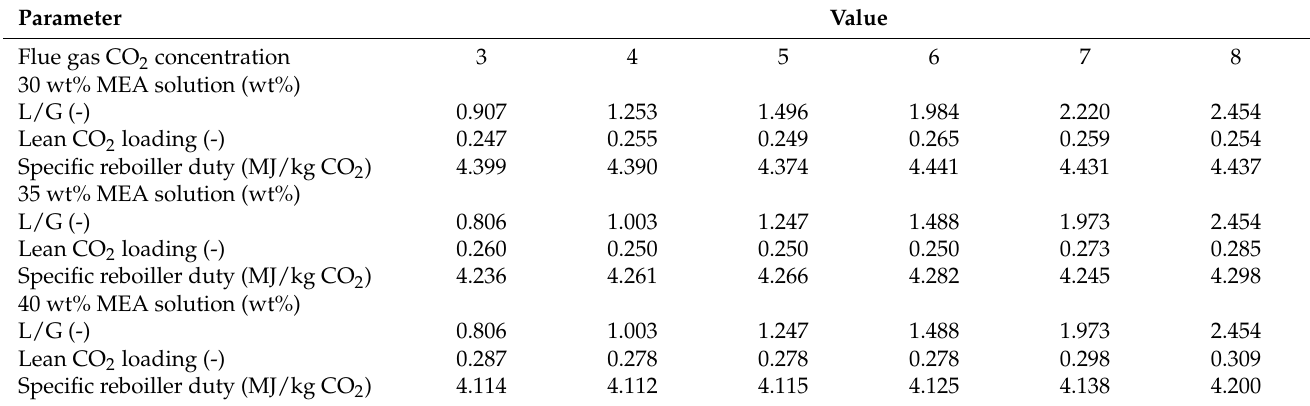
Table 7. Optimal liquid/gas ratio, lean loading, and specific reboiler duty for flue gas with CO 2 compositions from 3 to 8 mol% (adapted from